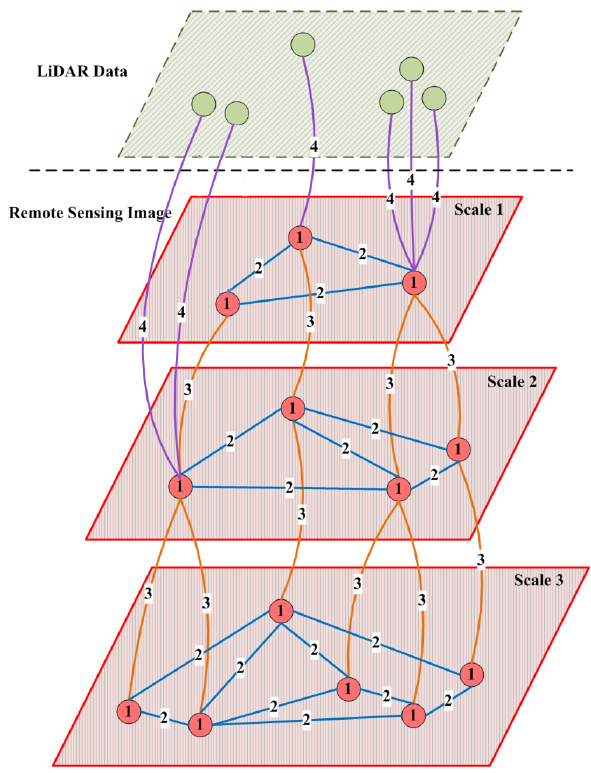
Figure 3: Illustration of the MSMSH-CRF model architecture. In Image level, red nodes (# 1) correspond to image regions, blue edges (# 2) linking red nodes represent the dependency between neighboring regions, and orange edges (# 3) linking red nodes in multi-scale indicate the hierarchical relation between regions at different scales corresponding to the multi-scale segmentation. In LiDAR level, green nodes represent the extracted regions. Purple edges (# 4) linking red and green nodes indicate the hierarchi- cal relation between regions from multi-source data, where the optimal scale of images is selected to match the LiDAR